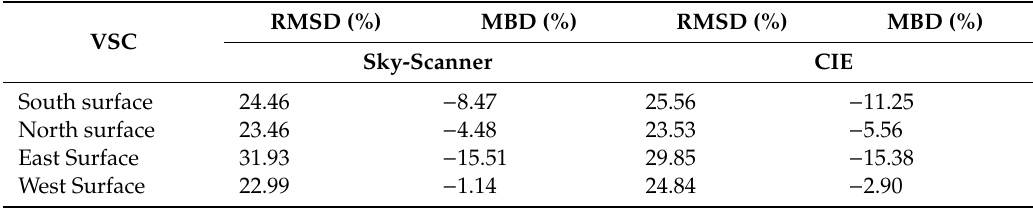
Table 6. RMSD and MBD results from the comparison between the VSC values calculated with the different approaches.